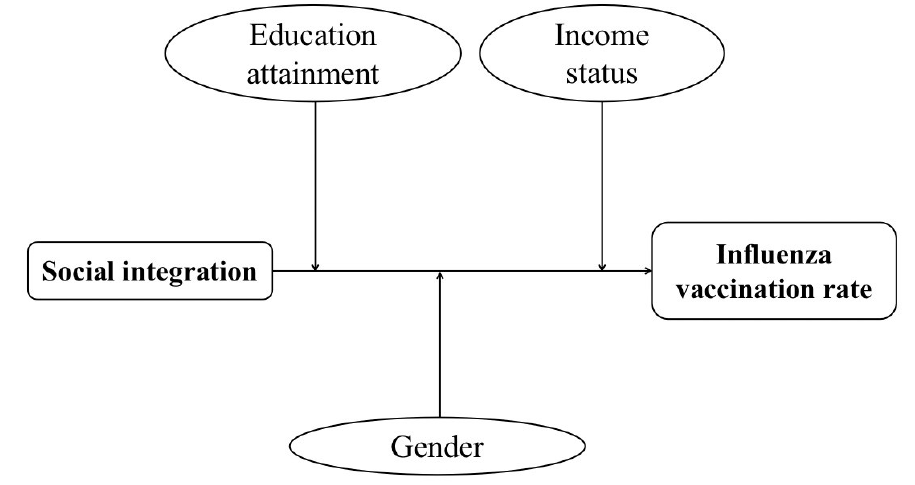
Figure 3. Adjusted framework of this study.